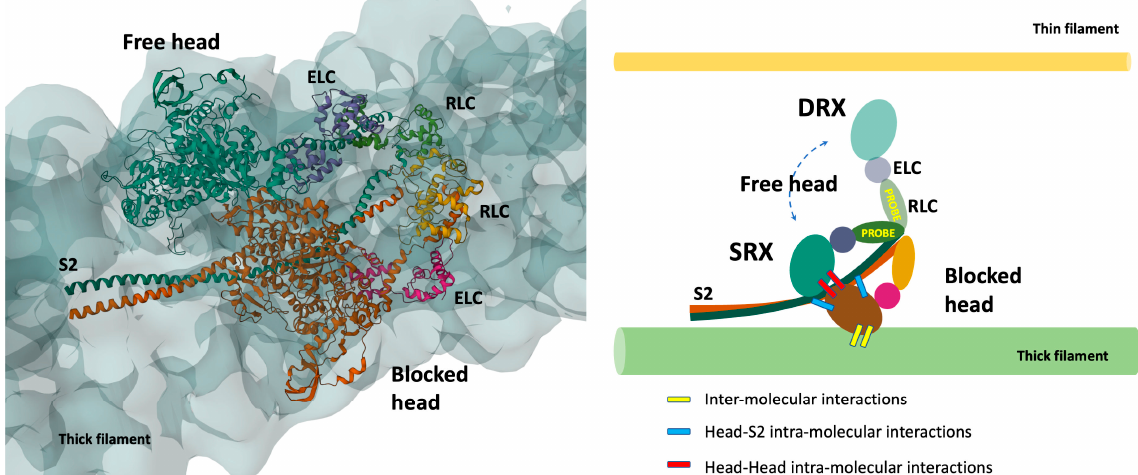
Figure 2. Schematic model of the Interacting Heads Motif (IHM), ( left panel, based on PDB: 5TBY) and cartoon model of myosin interactions involved in the formation and stabilization of the IHM ( right panel, based, redrawn and adapted from ref. [27]. Copyright 2017 E-life). IHM is associated with the SRX state, lying on the surface of the thick filament, with the blocked head primed in the pre-power stroke configuration, docked by intra-molecular interaction with its S2 (blue connections), and anchored by inter-molecular interactions with the neighboring myosin’s tail (yellow connections). The IHM is stabilized by intra-molecular interactions between the free head and the blocked head (red connections). The probes on the RLC are also schematically shown to describe the change in orientation during